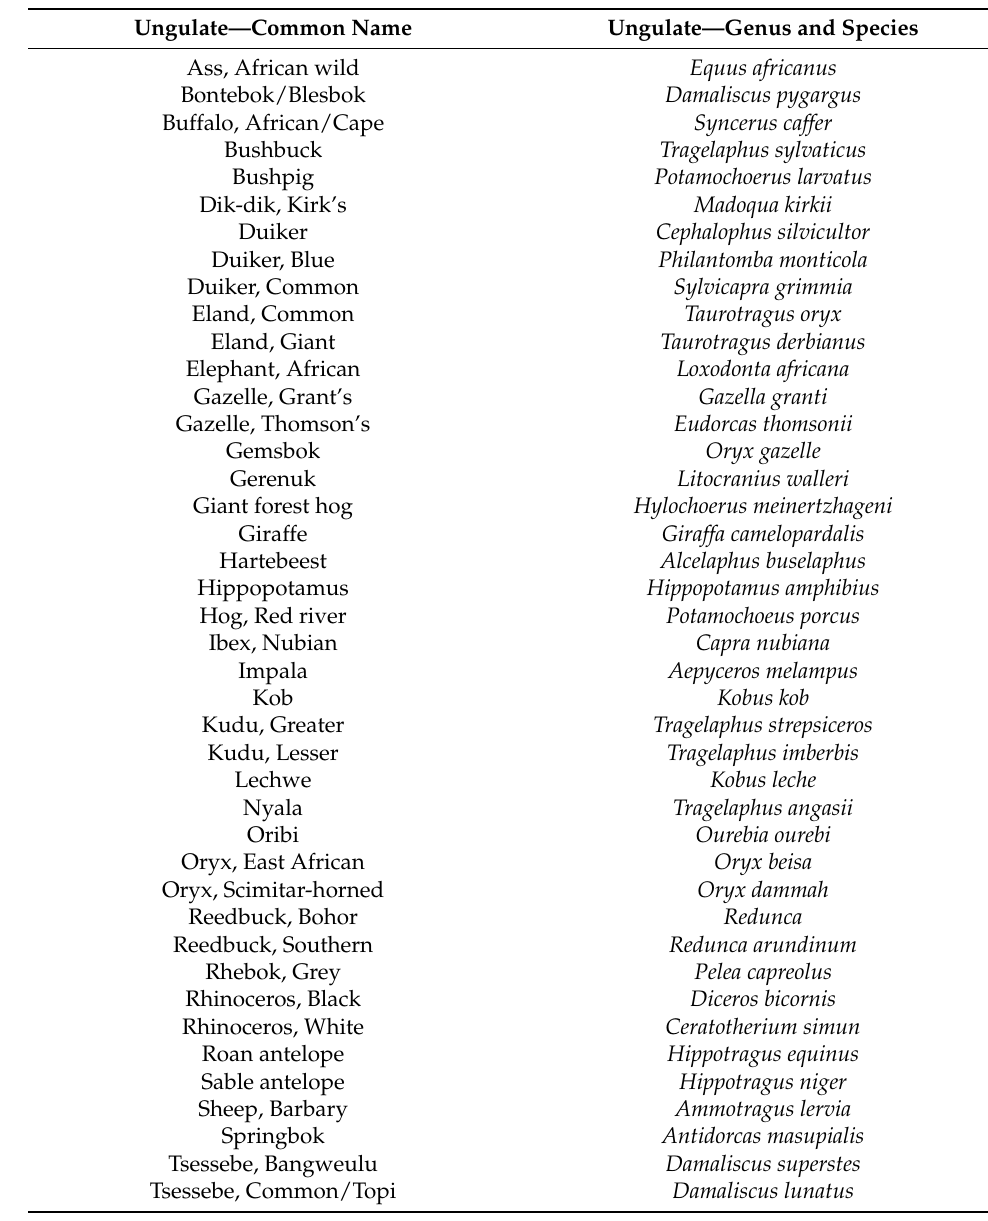
Table 4. List of African ungulate species, in alphabetical order, reported to have virus antigen and/or antibodies